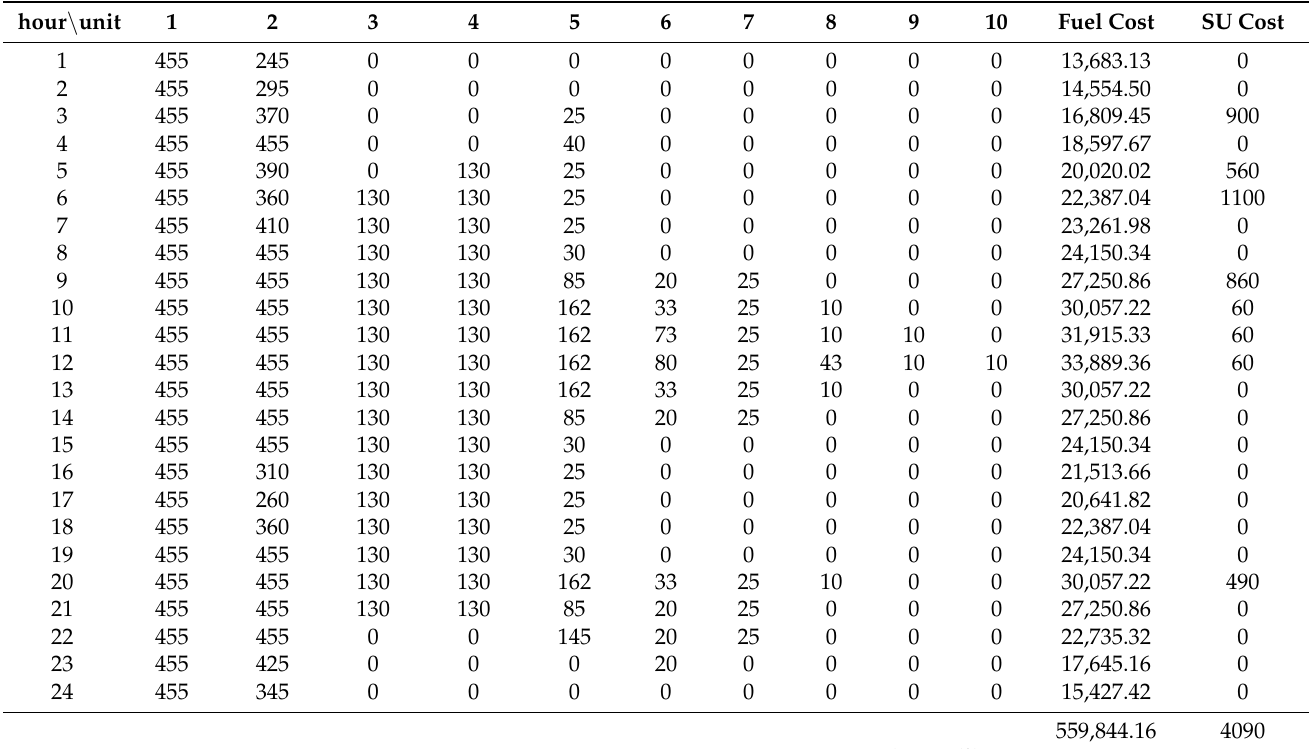
Table 11. Unit Commitment schedule and